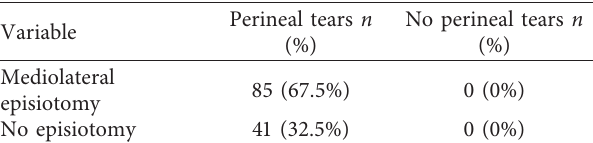
Table 2: Percentage of patients who underwent mediolateral episiotomy and sustained perineal tears.